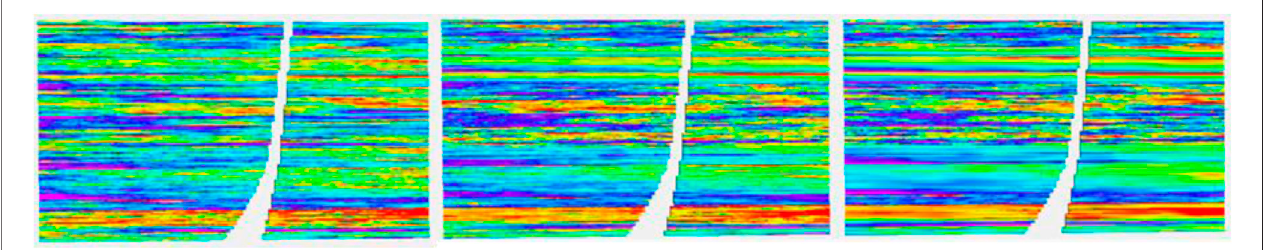
FIGURE 14 | (A) For eight wells; (B) For 36 wells. Each group is organized as mentioned before, Ember on the left, the Gaussian model on the right, correct variogram on the top, and short variogram